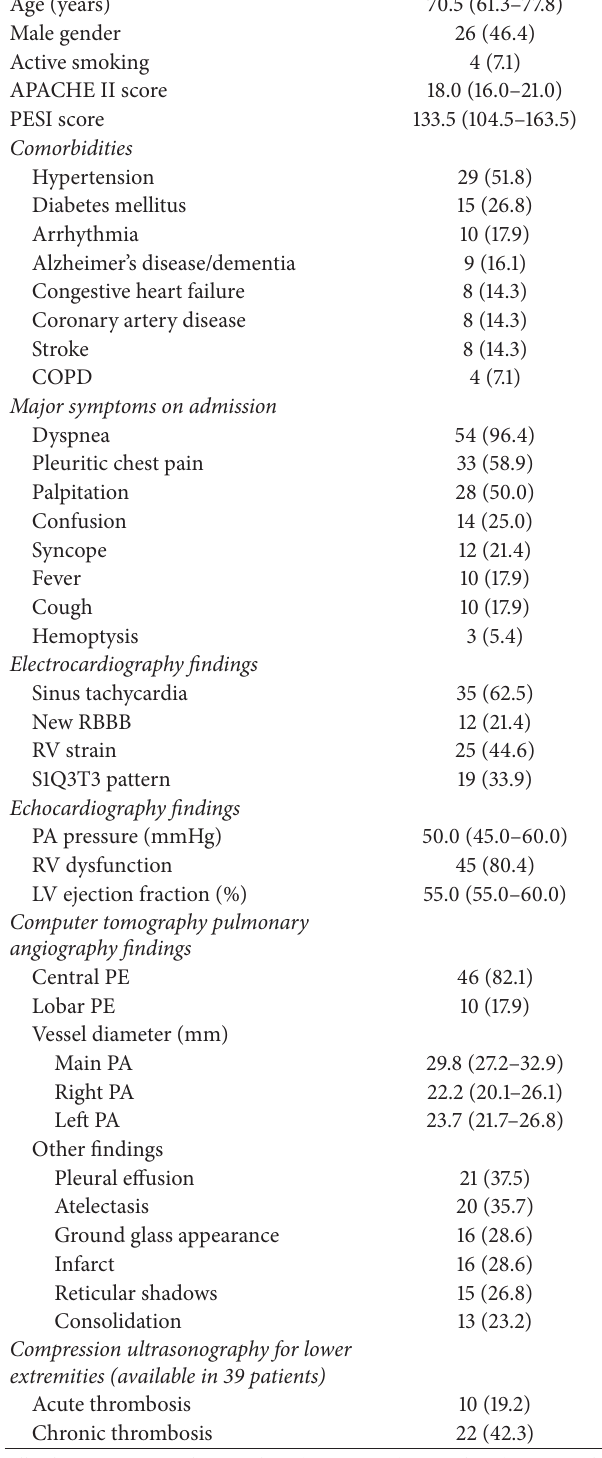
Table 1: Patient characteristics of study cohort ( 𝑛 = 56